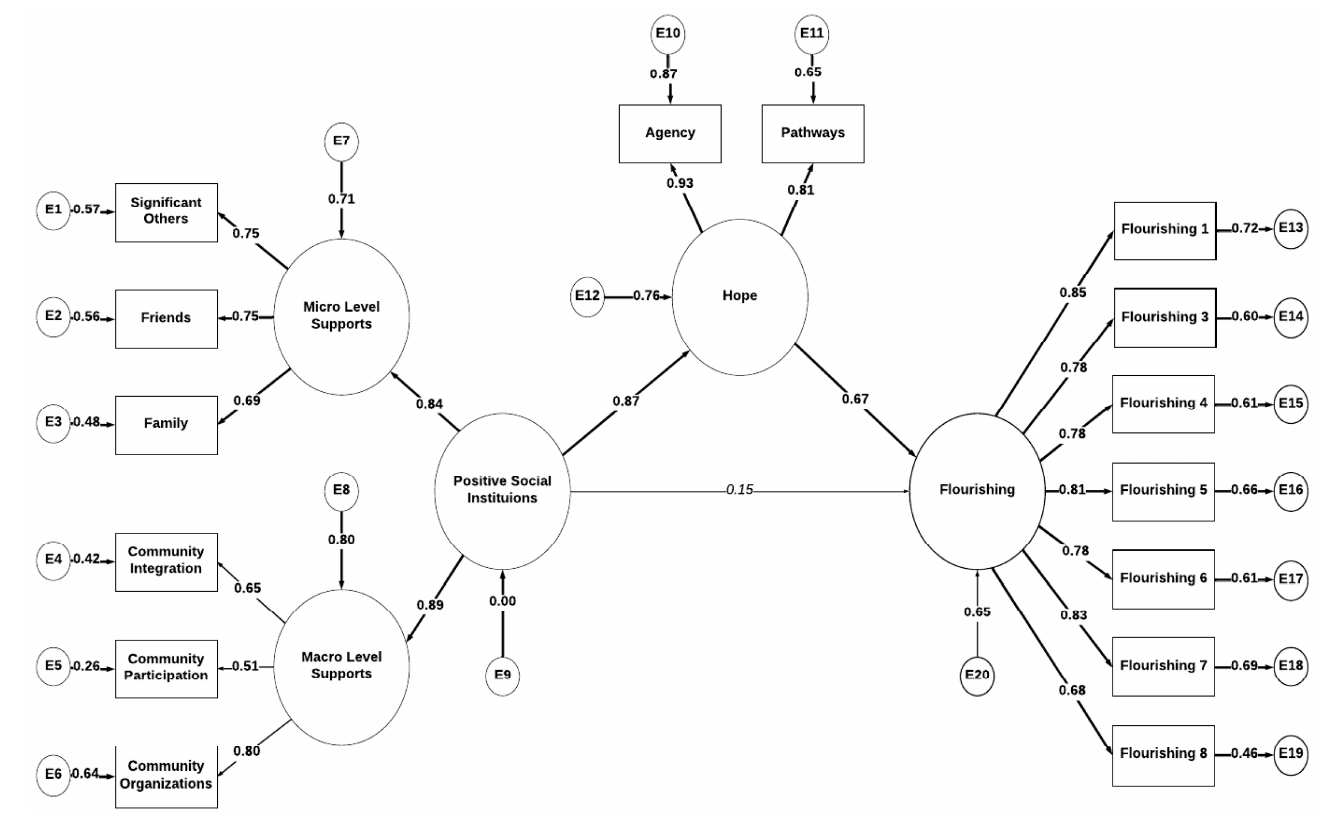
Figure 1. Standardized path coefficients for cisgender-heterosexual. Notes: path from X (positive social institutions) to Y (flourishing) not statistically significant p > 0.05. All other values significant p < 0.001. Table 4. Bootstrapped standardized effect sizes: sexual and gender